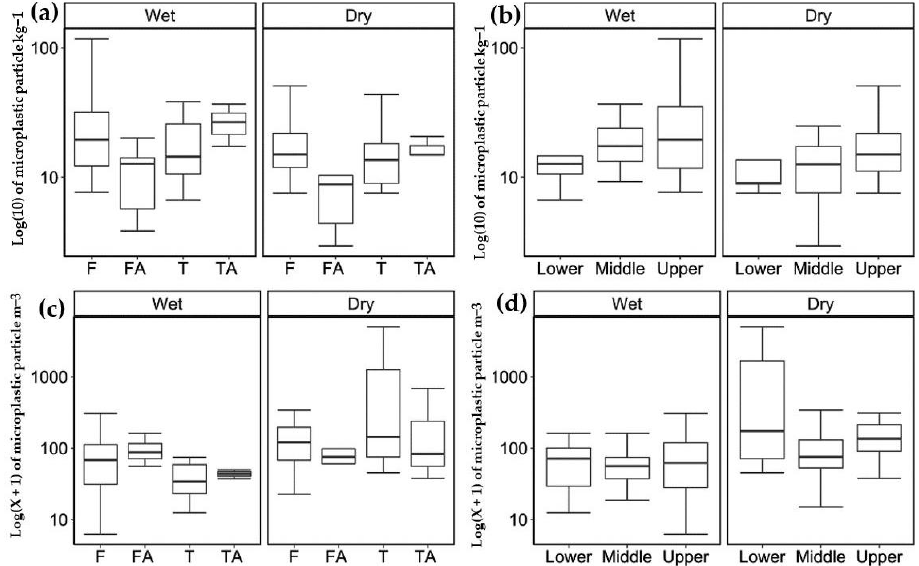
Figure 3. Box plot of microplastic abundance (sediment data were transformed to log(10) and surface water transformed to log(X + 1)) from 4 anthropogenic activities (F: fishing; FA: fishing and aquaculture; T: tourism; TA: tourism and aquaculture) and 3 regions (lower, middle and upper regions) in the Ubolratana Reservoir; ( a , b ) microplastic abundance in sediment and ( c , d ) in surface water.